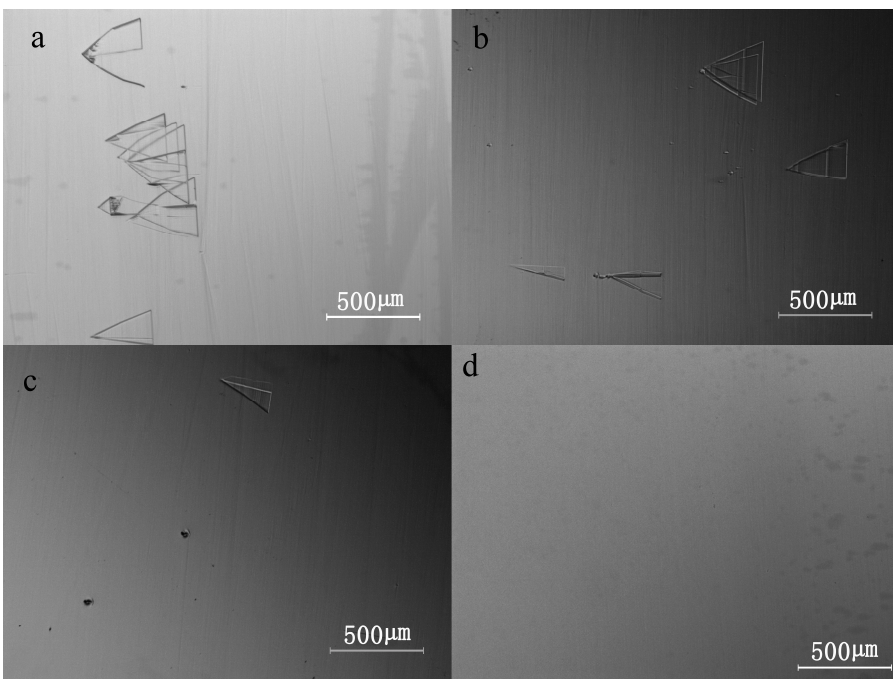
Figure 5. Optical microscopy images of approximately 20 μ m thick 4H-SiC epitaxial layers grown under different pressures: ( a ) 100 mbar; ( b ) 80 mbar; ( c ) 60 mbar; ( d ) 40 mbar. Table 1. Triangular defect densities and results of Gauss fit of full width at half maximum (FWHM) for epitaxial layers grown at pressure from 40 to 100